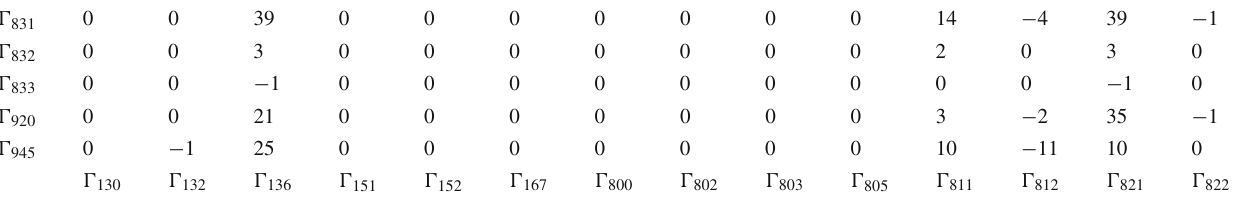
Table 313 Basis quantities correlation coefficients in percent, subtable